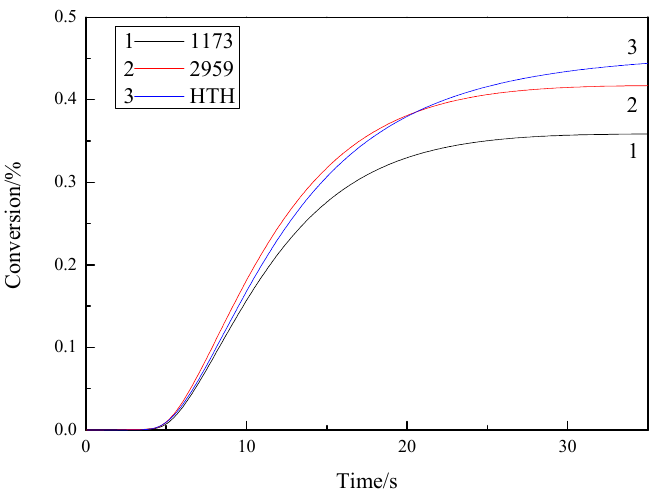
Figure 9. Curves of 1173, 2959, and HTH-initiated polymerization conversion rate of TMPTA.